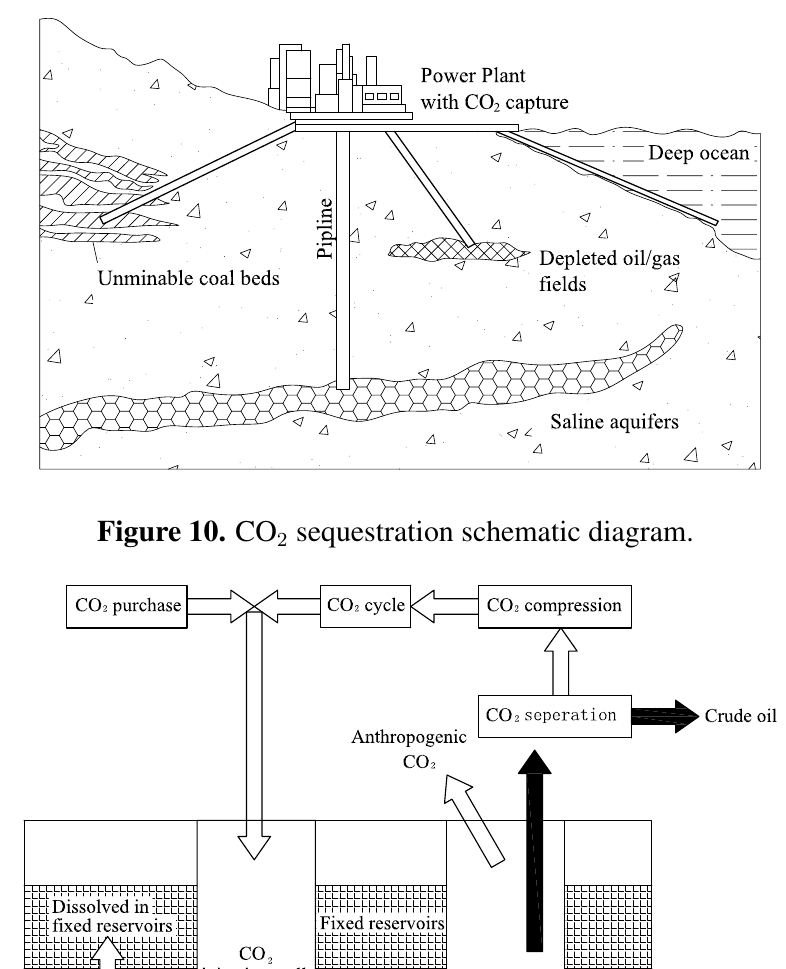
Figure 9. Technical trajectories of the CO